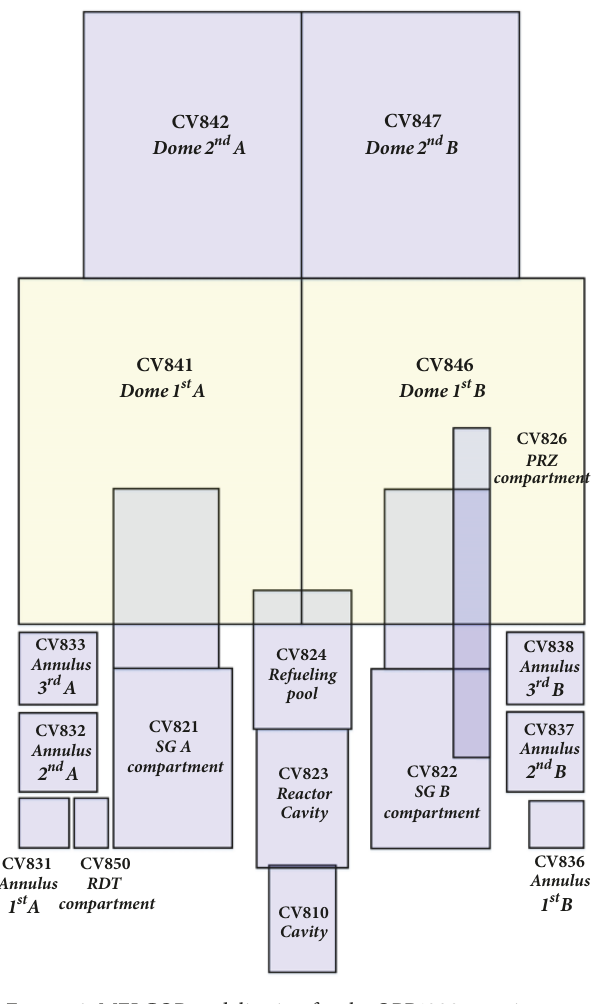
Figure 3: MELCOR nodalization for the OPR1000